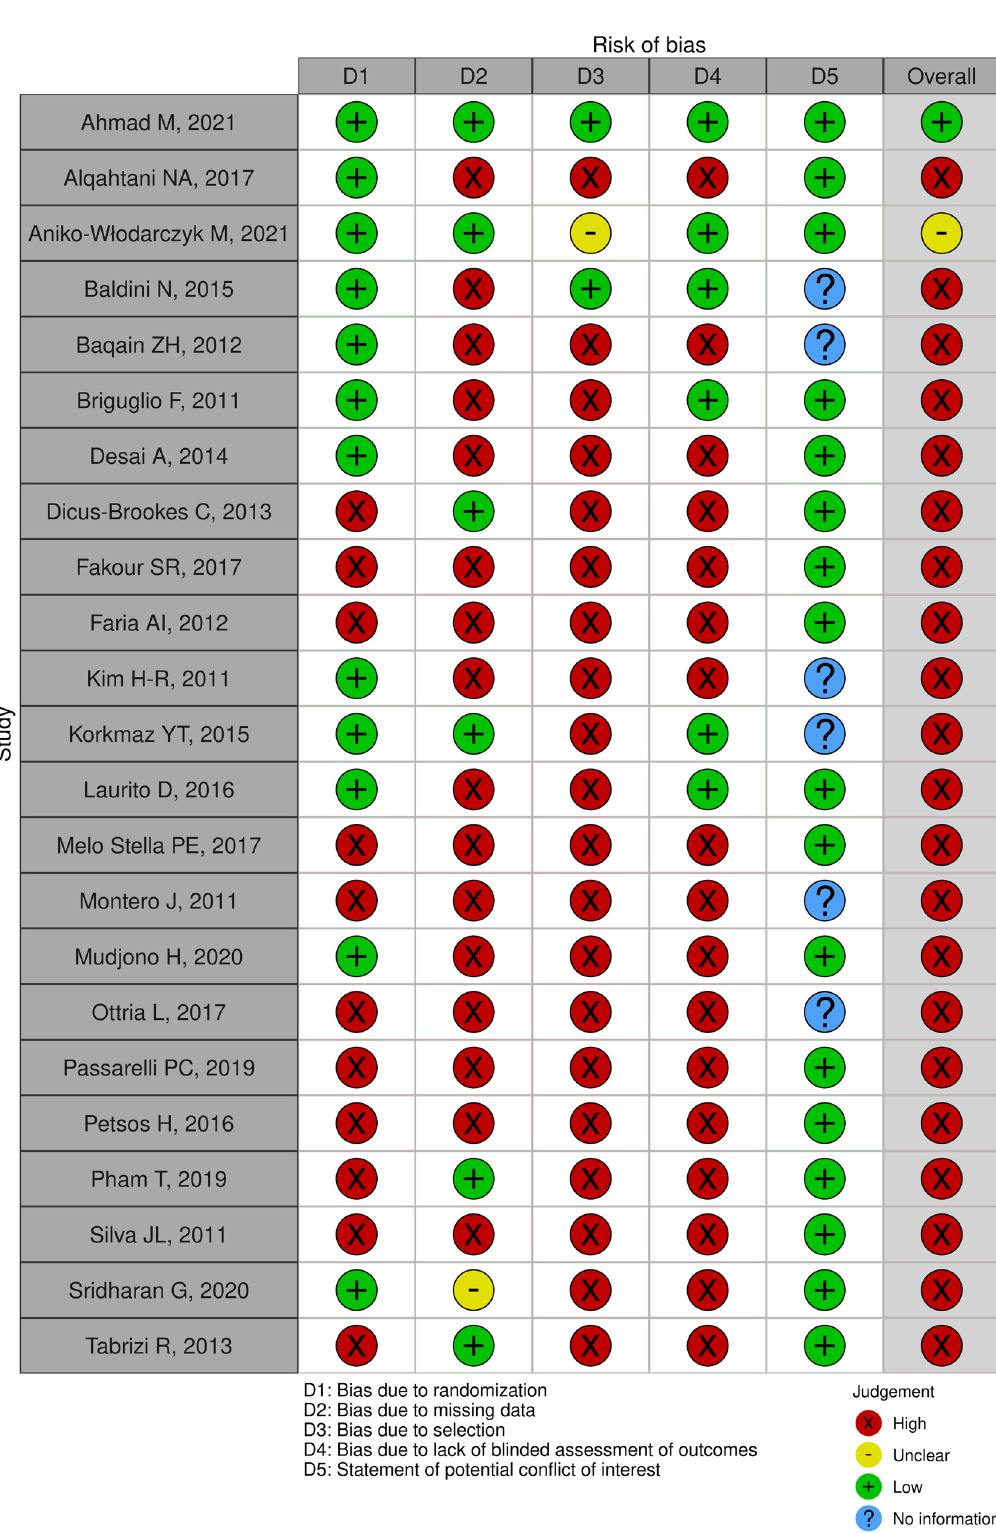
Fig. 2. Quality assessment of the included studies. Quality assessment of each included study using the Cochrane Risk of Bias Tool